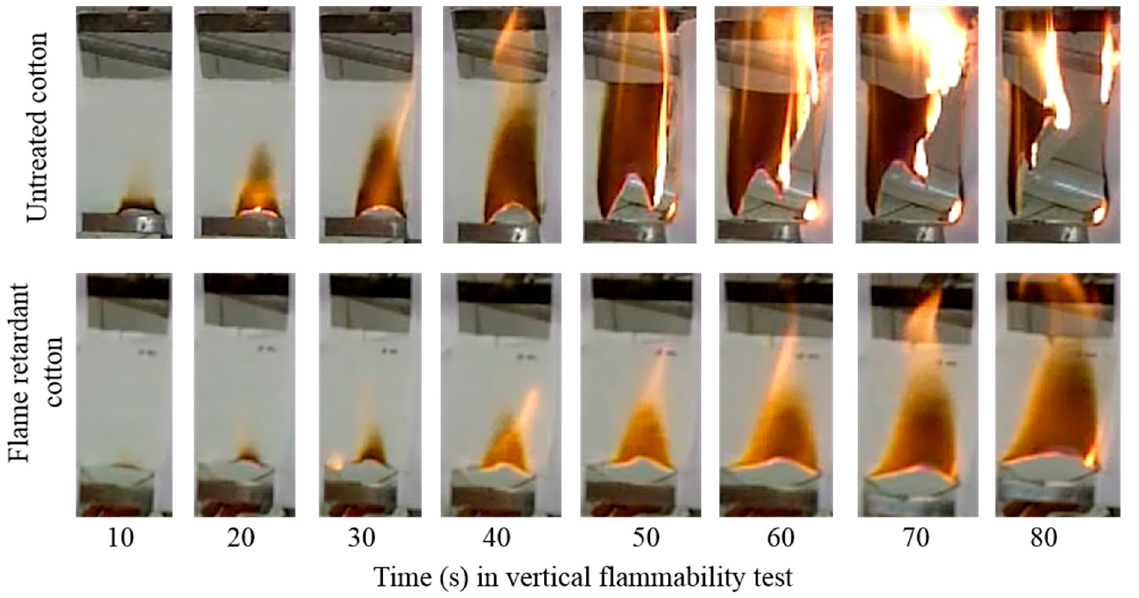
Figure 7. Flammability of untreated and flame-retardant cotton at different intervals of time.